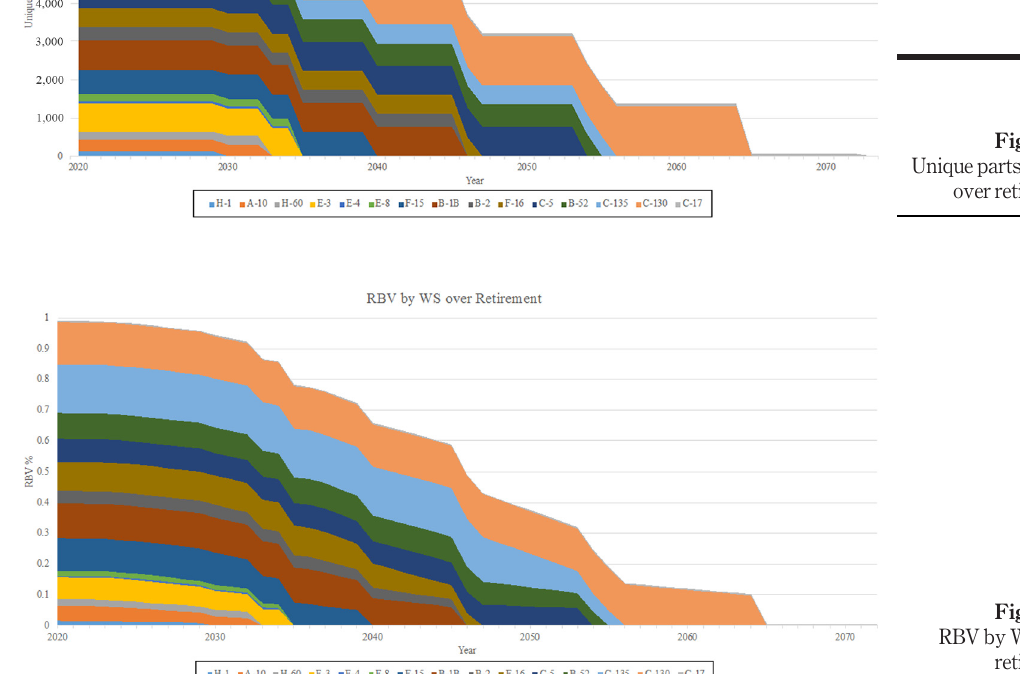
Figure 8. RBV by WS